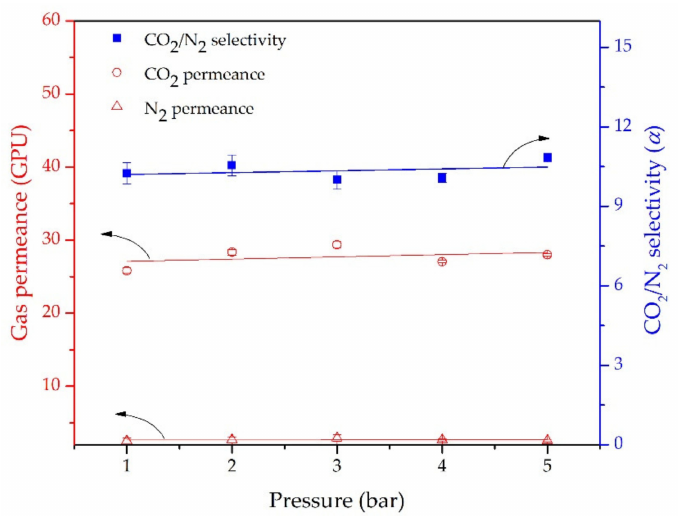
Figure 11. Effect of feed pressure on the gas permeance and ideal selectivity of CO 2 /N 2 at 25 ◦ C for the modified P15